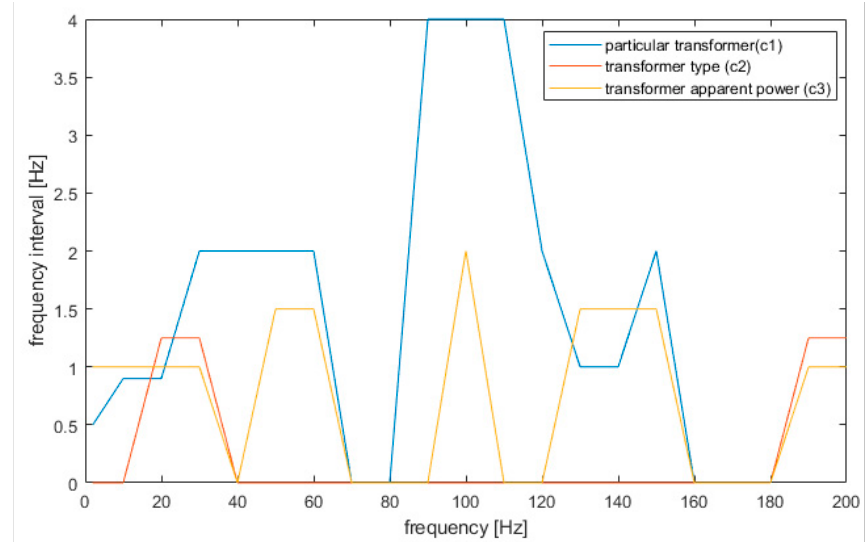
Figure 10. The data usefulness for classification and detection.